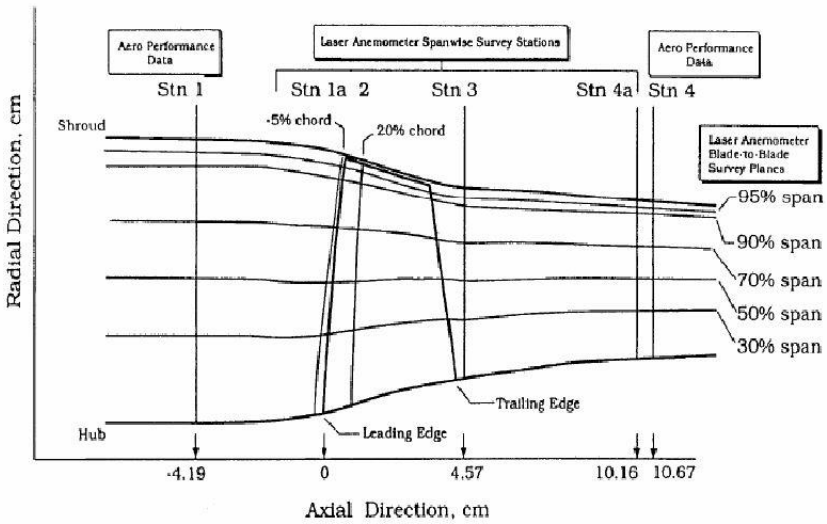
Figure 1. measurement positions of the experiment (from NASA). Figure 1. Measurement positions of the experiment (from